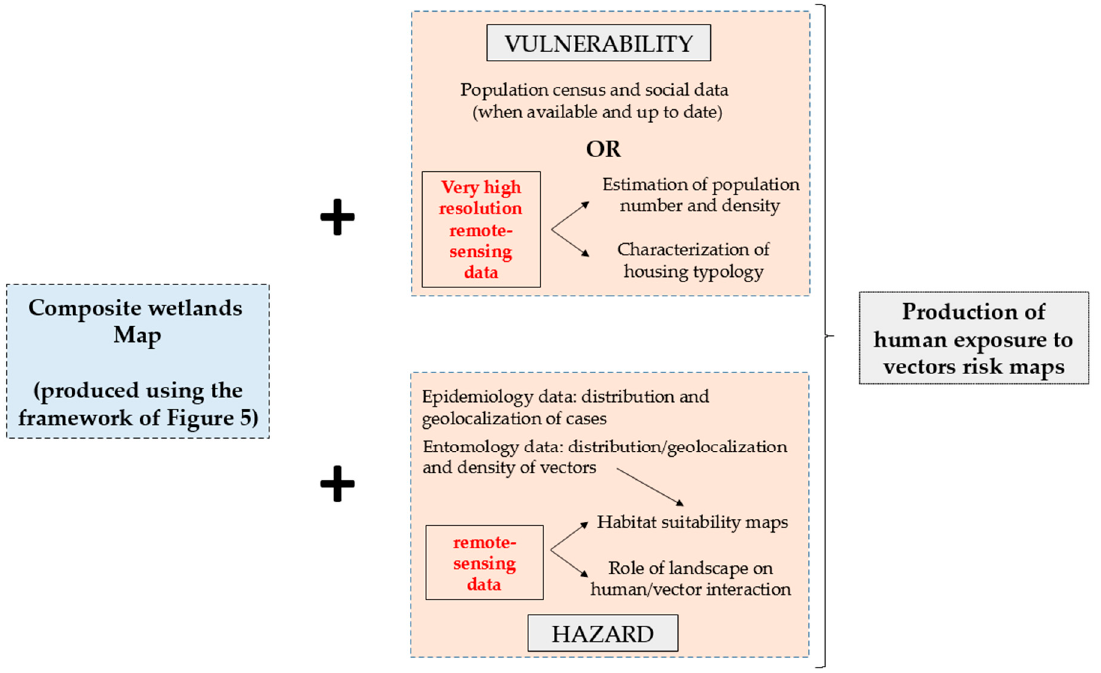
Figure 10. The contribution of remote-sensing and land cover mapping using optical and SAR data in the definitions of hazard and vulnerability for the production of human exposure to vector risk maps.